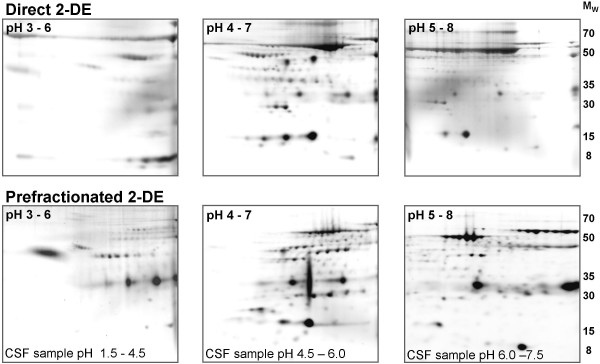
Comparison of direct and prefractionated CSF on SYPRO Ruby stained 2-D gels. The upper figures represents standard images of direct 2-DE, and the lower figures represents prefractionated 2-DE. The pH interval of the IPG strips is denoted in the upper left corner of the gels and the pH range of the prefractionated CSF samples at the bottom of the gel images. Molecular weights (MW) are in kDa.